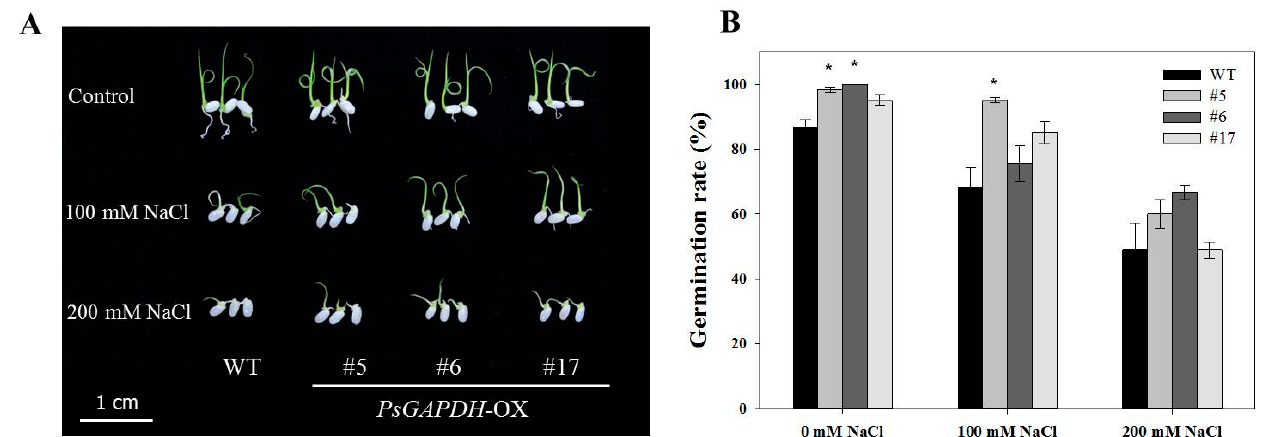
Figure 2. Seed germination rate of PsGAPDH -OX transgenic plants under salt stress. ( A ) Seed germination phenotypes of wild-type (Control) and PsGAPDH -OX plants treated with 100 mM or 200 mM NaCl for 5 days. ( B ) Graph of germination rates. For each treatment, 15 seeds were measured. Error bar represents the SD of three replicates. Significant differences depending on t -tests are indicated by asterisks (*, p < 0.05).